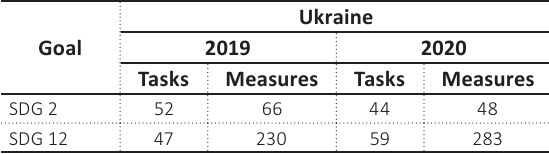
Table 1. Incorporation of tasks for achieving SDGs 2 and 12 into state strategic